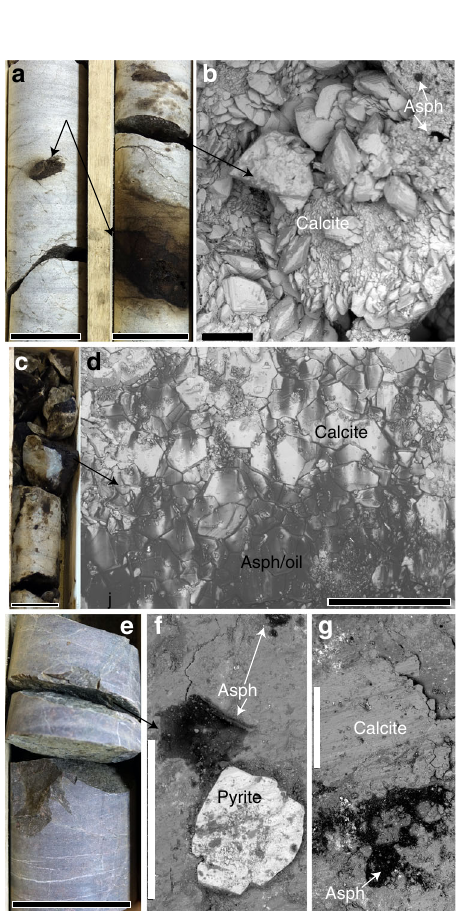
Fig. 3 Appearance and paragenesis of solid bitumen and seep oil. ( a – d ) from sedimentary rock fractures ( e – g ) from crystalline rock